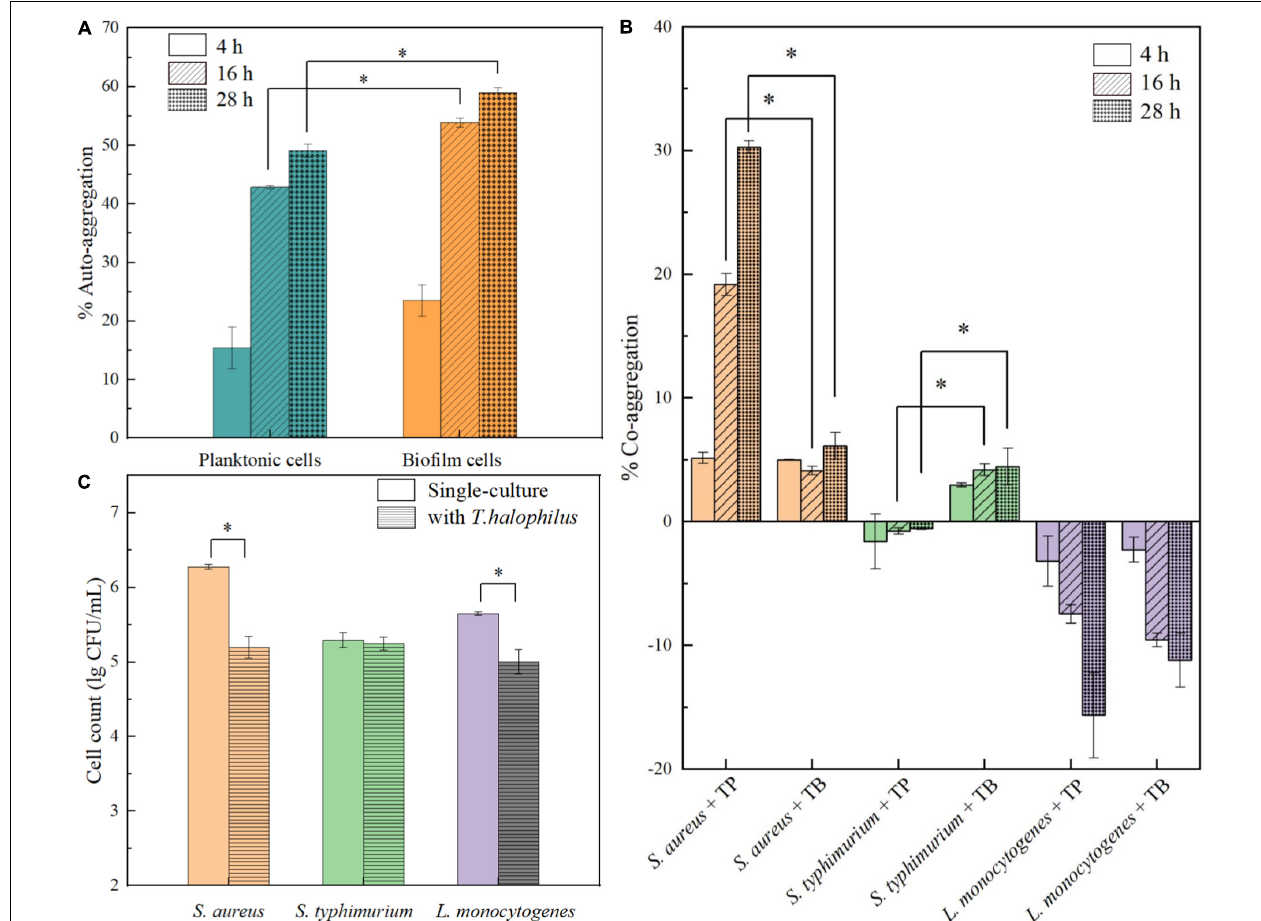
FIGURE 8 | Anti-pathogenic activities of T. halophilus biofilm. (A) Auto-aggregation of T. halophilus planktonic and biofilm cells after 4, 16, and 28 h. (B) Co-aggregation of pathogenic strains with T. halophilus planktonic (TP) or biofilm cells (TB) after 4, 16, and 28 h. (C) Biofilm cell counts of pathogenic bacteria after incubation at 37 ◦ C for 48 h with T. halophilu s biofilms. Asterisk indicates significant difference ( p <